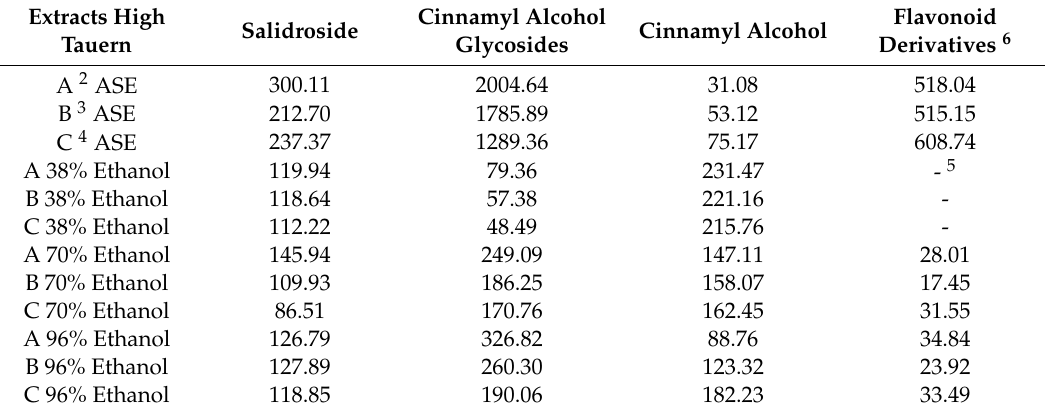
Table 7. Total contents for investigated substance groups for extracts from collection site High Tauern (mg / 100 g plant material 1 ).